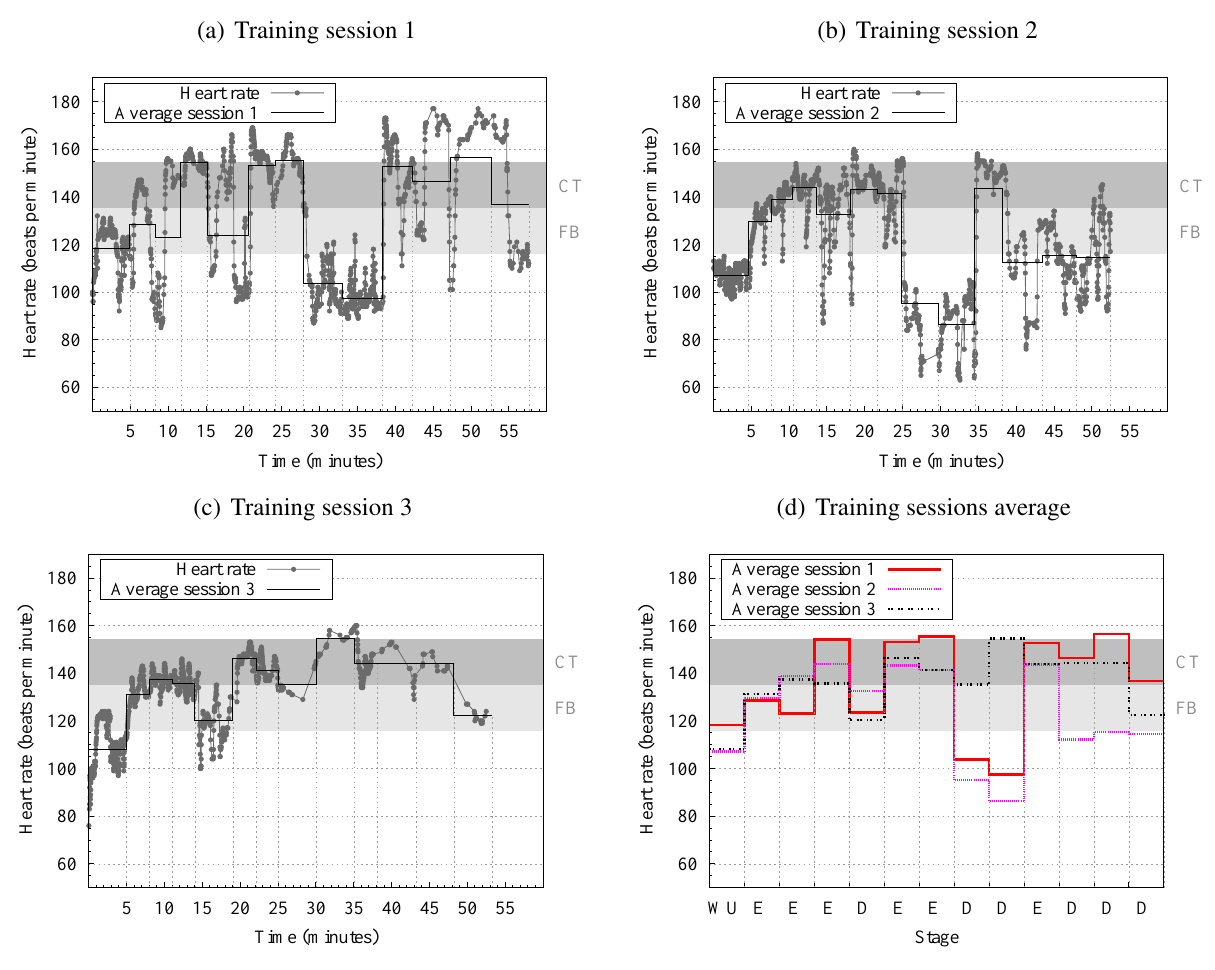
Figure 5. HR evolution in three training